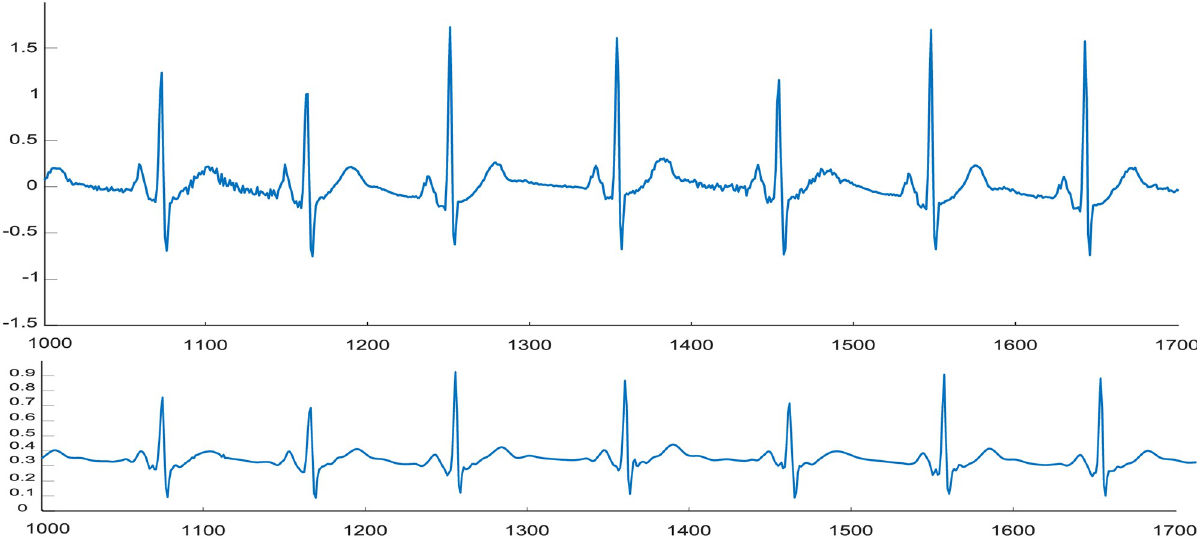
Fig 2. Preprocessing ECG segments. (a) Part of an original ECG segment. (b) The denoised and scaled version.